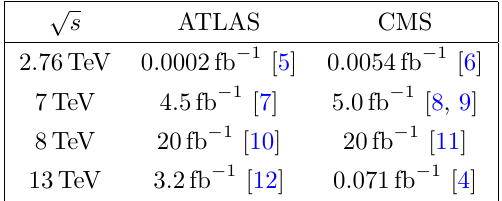
Table 1 . Recent measurements of inclusive jet production, performed by the ATLAS and CMS √ Collaborations at different s , with the corresponding integrated